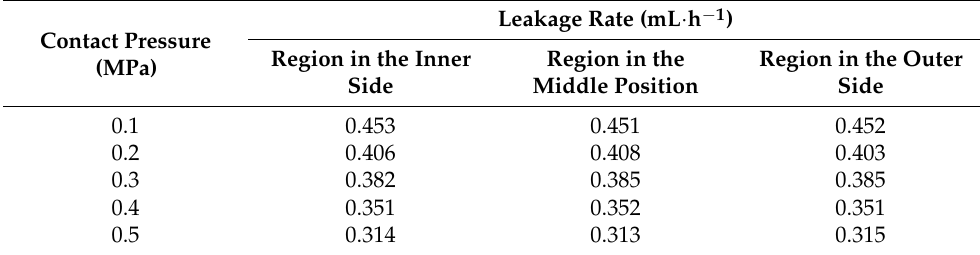
Table 1. Leakage rates calculated in different locations.